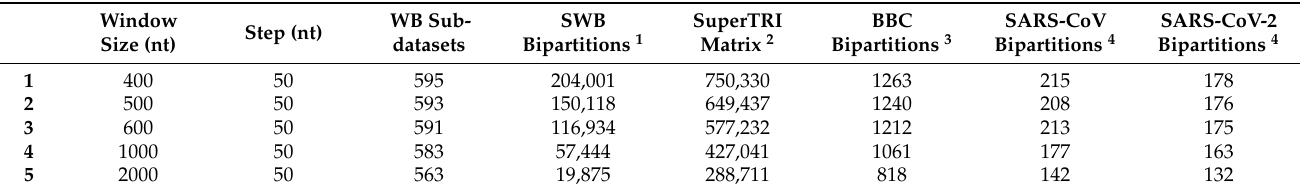
1 : Number of bipartitions (with window bootstrap percentages (WBP) calculated for each WB subdatasets) obtained under the SWB program [9]; 2 : Number of characters in the MRP matrix reconstructed using LFG [9] and SuperTRI [21] programs; 3 : Number of SWB bipartitions including at least one WBP ≥ 50% selected under the BBC program using the SWB file as input [9]; 4 : Number of BBC bipartitions selected under Microsoft ® Excel using the BBC file as